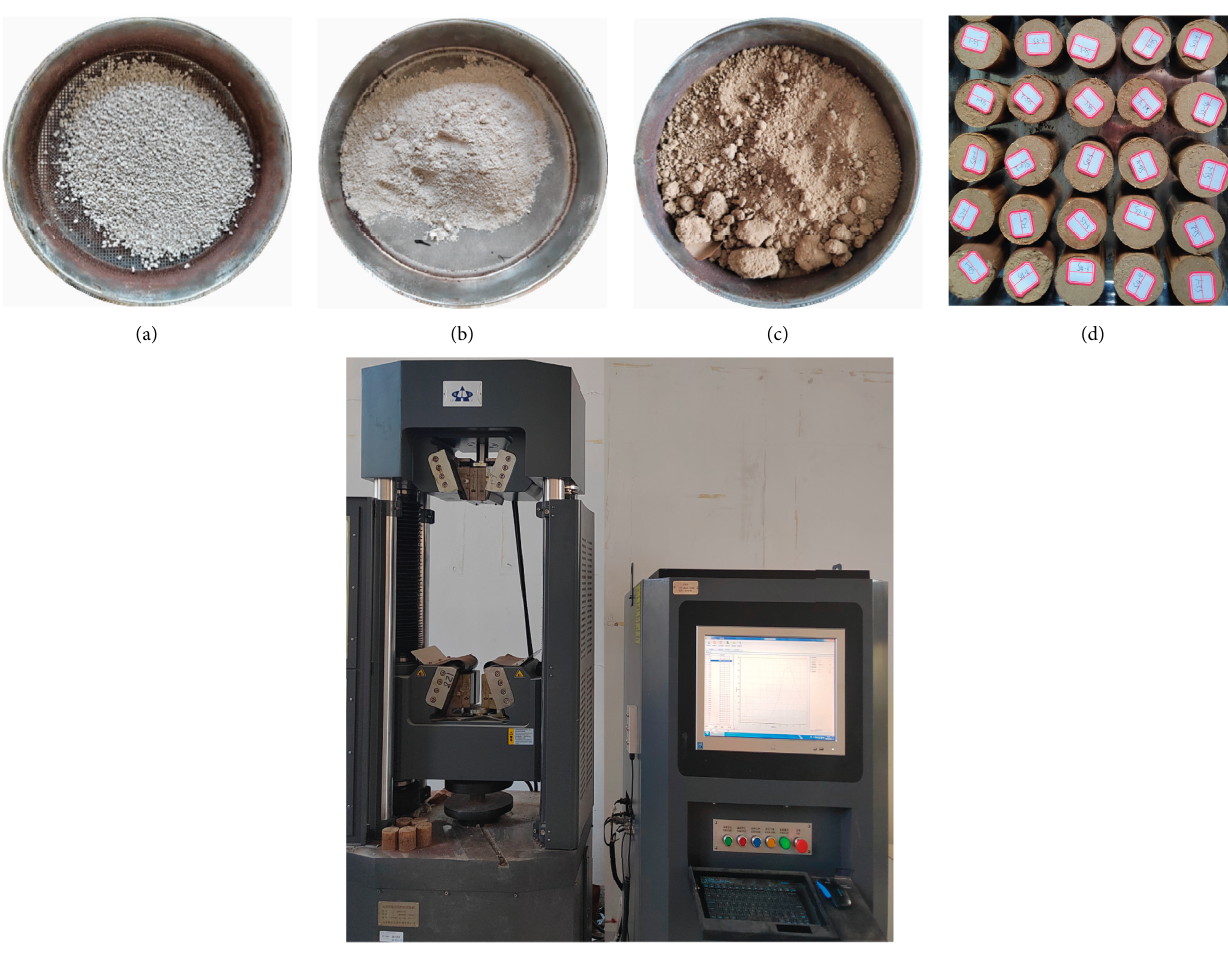
Figure 3: Raw materials and test processes. (a) SR; (b) lime; (c) soil; (d) specimen; (e) SANS-300 hydraulic